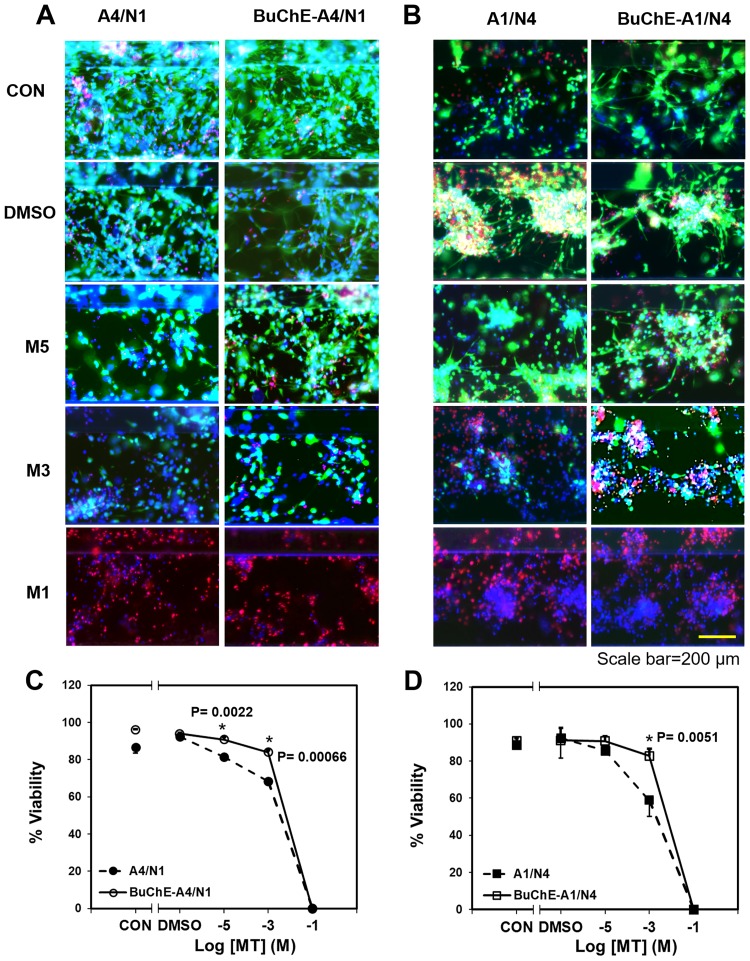
Cell viability following acute MT exposure and BuChE post-treatment in A4/N1 (A, C) and A1/N4 (B, D) groups.Representative live/dead images of 3D co-cultured cells (A. A4/N1, B. A1/N4) exposed to MT with and without BuChE post-treatment. Viability quantification of co-cultured cells A4/N1 (C) and A1/N4 (D). * represents significant difference of cell viability between with and without BuChE (P = 0.0022, 0.00066 for A4/N1 group treated with 10−5, 10−3 M MT, respectively, P = 0.0051 for A1/N4 group treated with 10−3 M MT).